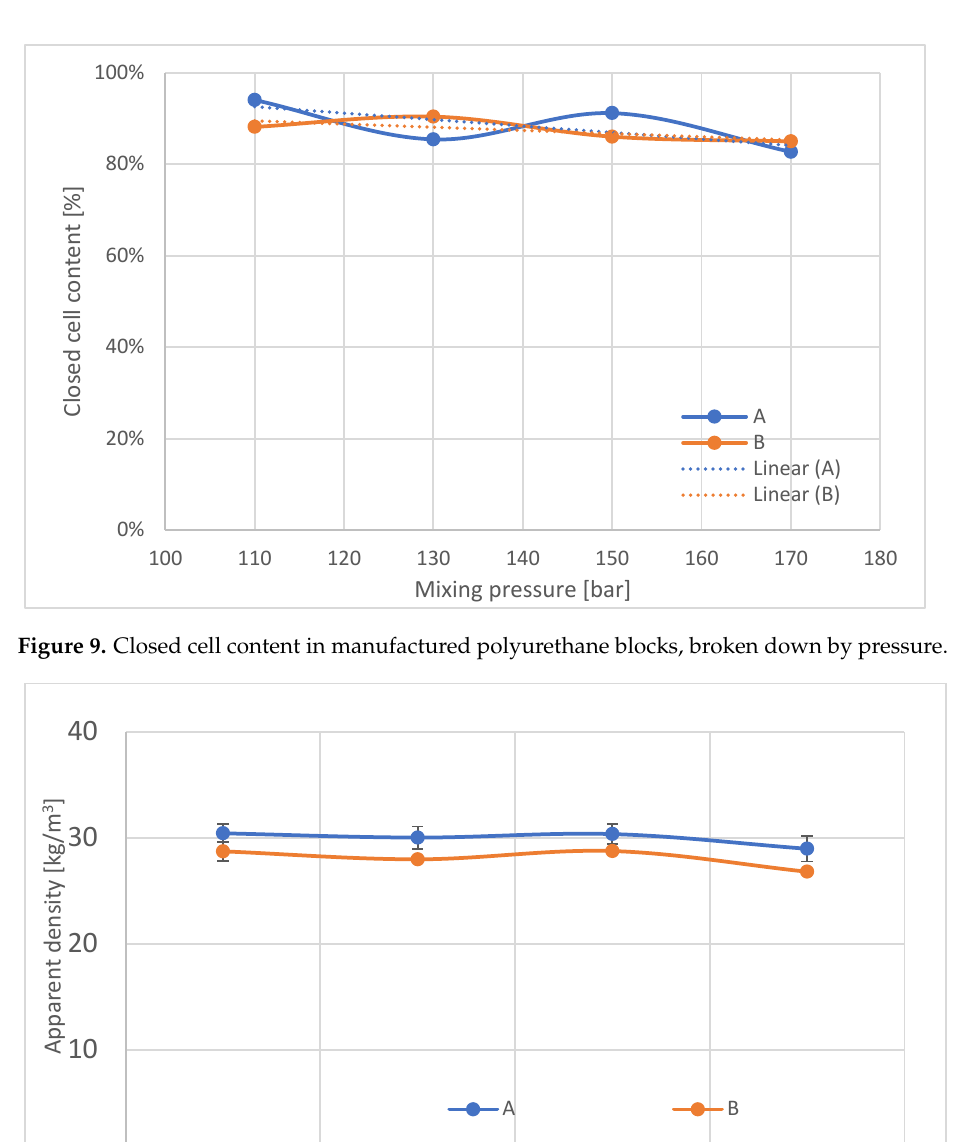
Table 3. The differences of apparent density between localization in blocks.